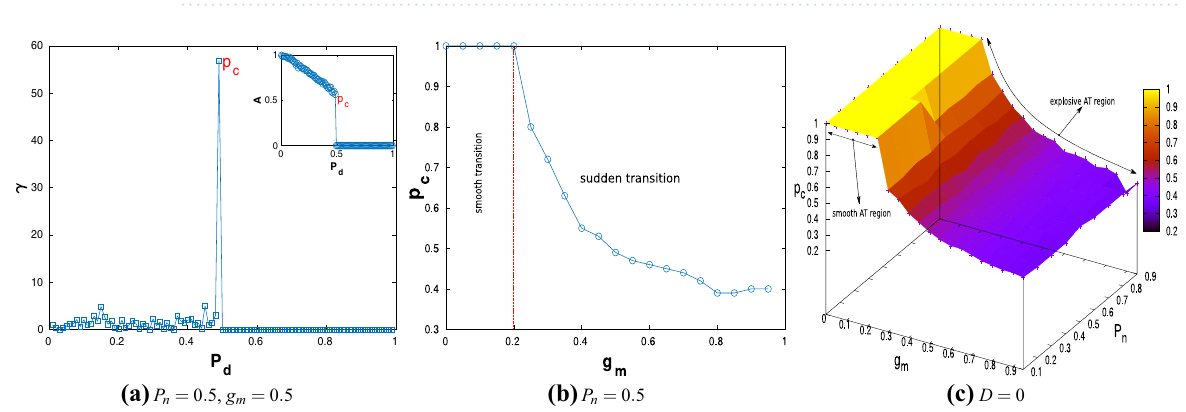
Figure 5. ( a ) Variation of γ with P d ; a peak is observed when explosive AT occurs (inset shows the corresponding variation of A with P d ). ( b ) Variation of p c with g m for P n = 0.5 . ( c ) Global variation of p c with P n and g m